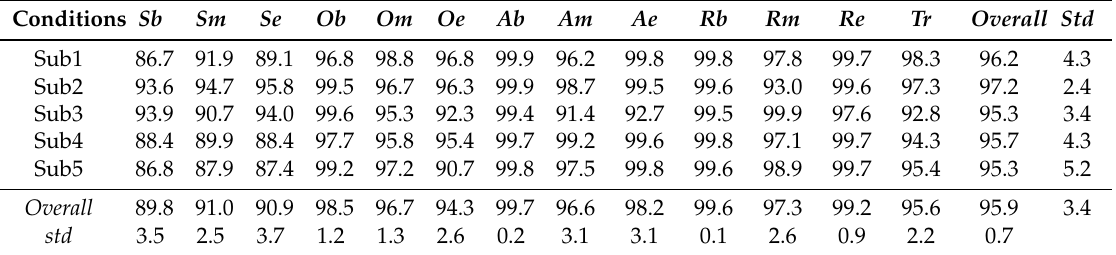
Table 7. The component level recognition result at Θ = 3(%) (Sub3 as reference subject).